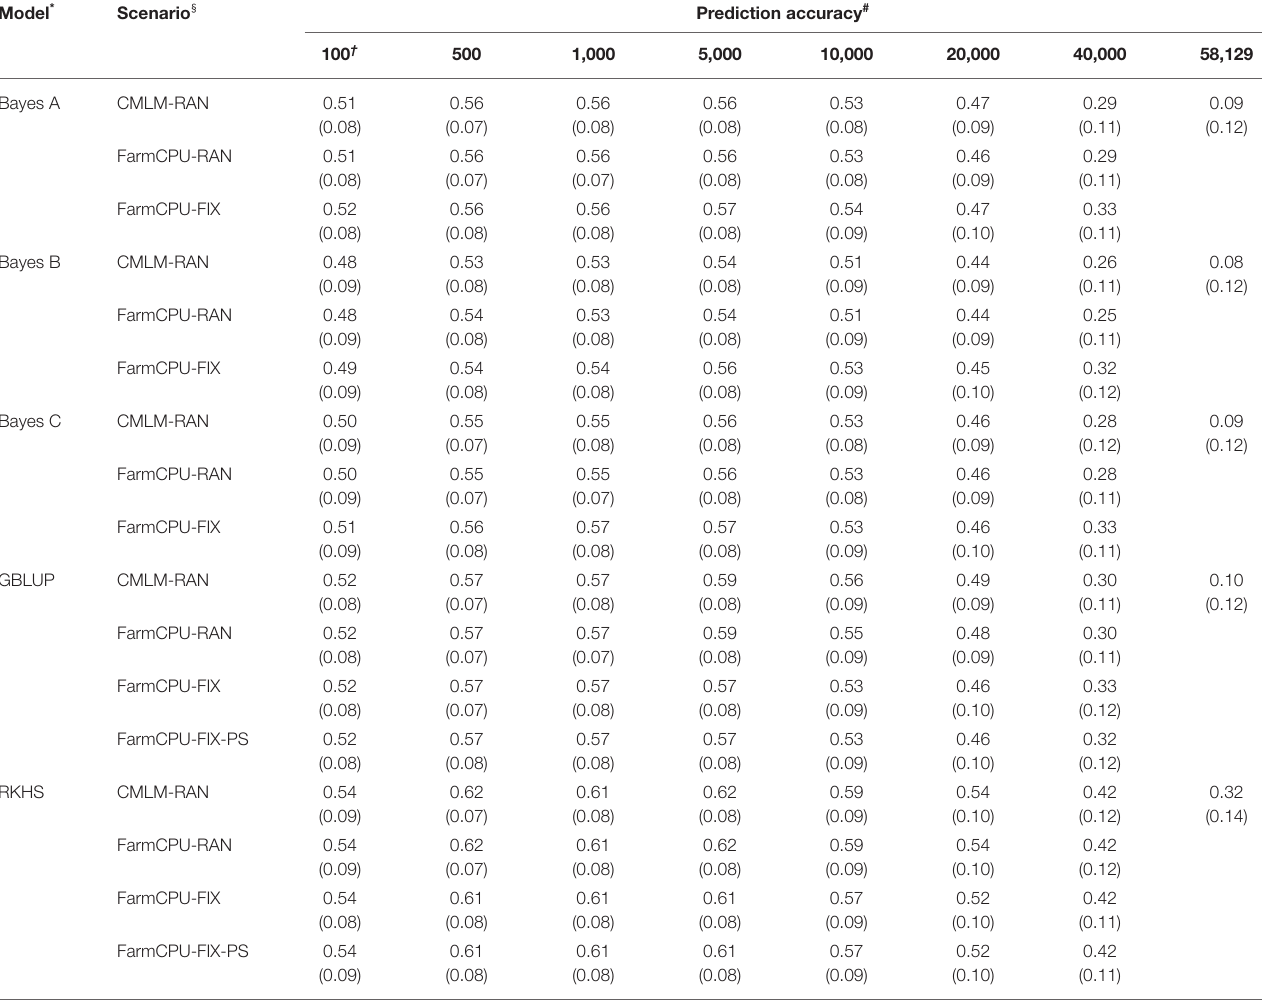
TABLE 2 | Prediction accuracy of random model, fixed model, and population structure model based on trait-associated markers in five prediction models for grain yield per plant. Model